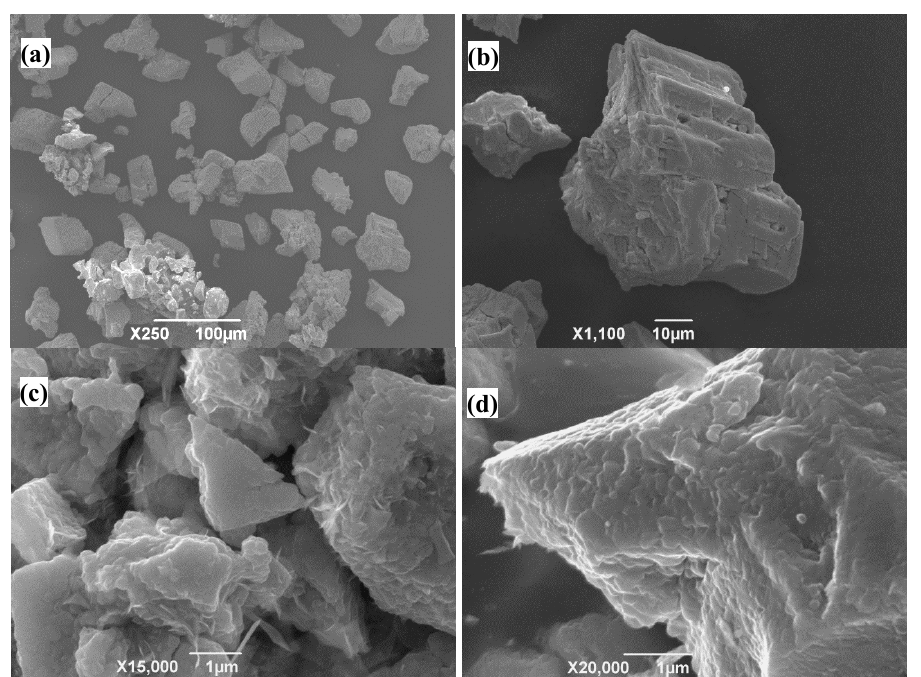
Figure 5. SEM images of samples from experiment AHS1, exhibiting the original shape and size of the APT ( a and b ), and the nanostructural feature within the agglomerates ( c and d